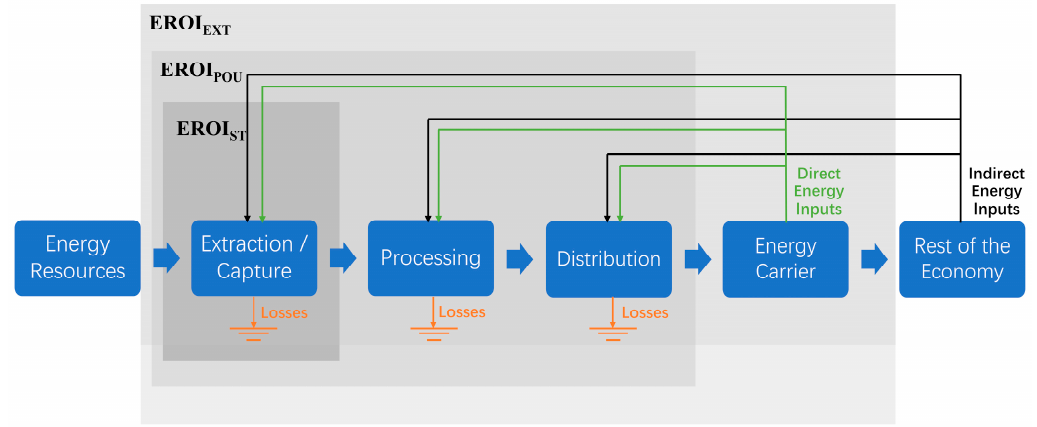
Figure 1. Types of EROI. Standard EROI (EROI ST ), point-of-use EROI (EROI POU ) and extended EROI (EROI EXT ).